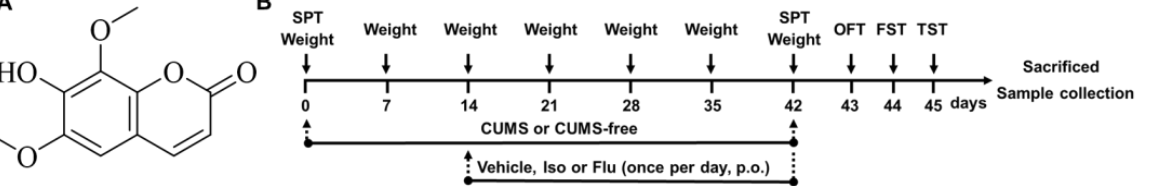
Figure 1. The chemical structure and experimental design. ( A ) The chemical structure of isofraxidin. ( B ) The experimental protocol. CUMS, chronic unpredictable mild stress. Iso, Isofraxidin. FLU, fluoxetine hydrochloride. SPT, sucrose preference test. OFT, open field test. FST, forced swimming test. TST, tail suspension test.